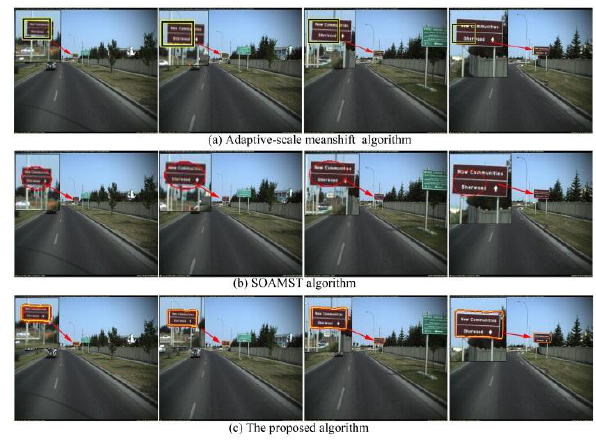
Figure 6. OOI segmentation results for real-world DMI sequence in MMS.